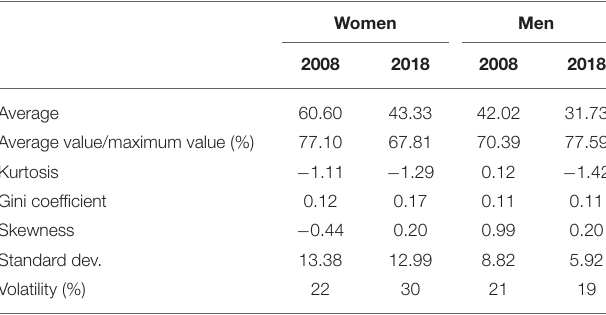
TABLE 3 | KILM 6—descriptive statistics for the years 2008 and 2018.